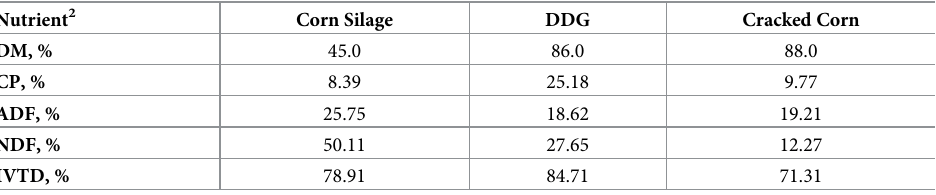
Table 1. Nutrient composition corn silage, dried distillers’ grain (DDG), and cracked corn (dry matter basis) 1 . Nutrient 2 Corn Silage DDG Cracked Corn DM, % 45.0 86.0 88.0 CP, % 8.39 25.18 9.77 ADF, % 25.75 18.62 19.21 NDF, % 50.11 27.65 12.27 IVTD, % 78.91 84.71